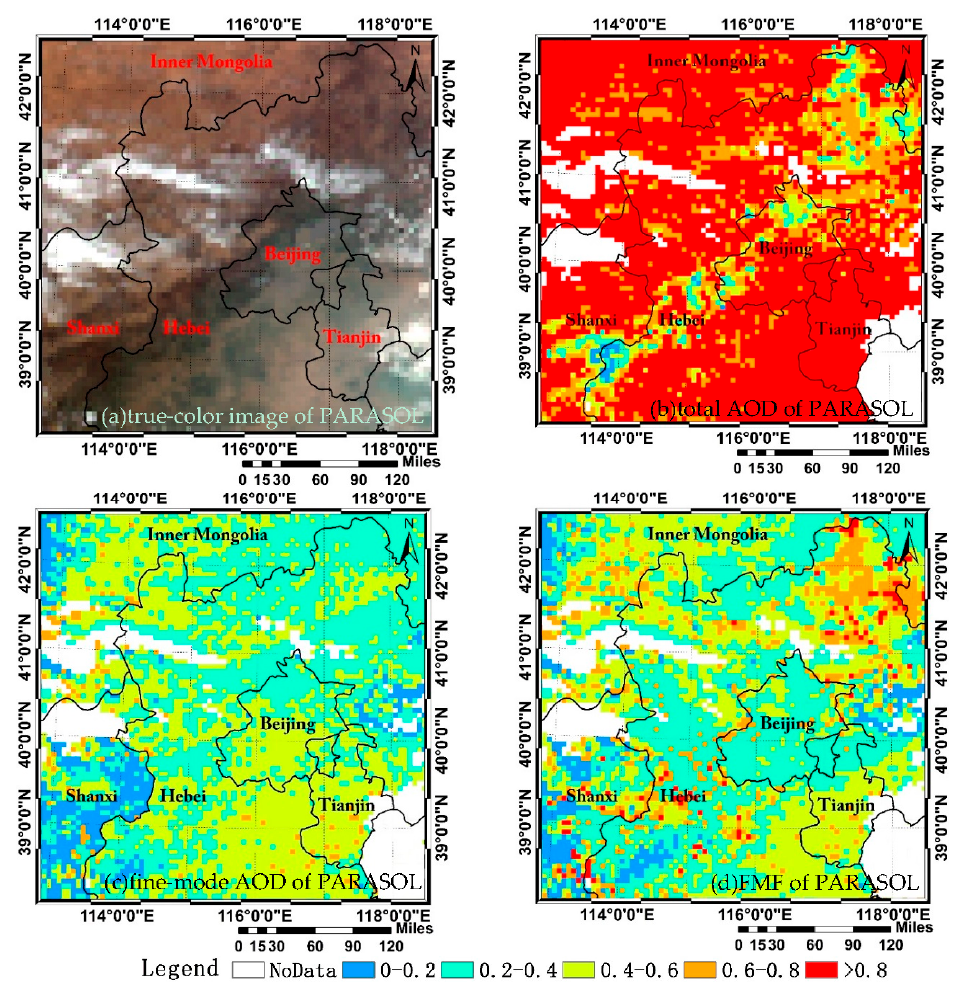
Figure 3. The retrieval results of PARASOL for 28 April 2012. ( a ) is a true-color image, and ( b ), ( c ), and ( d ) are the retrieval results of the total AOD (865 nm), fine-mode AOD (865 nm), and FMF (865 nm), respectively.